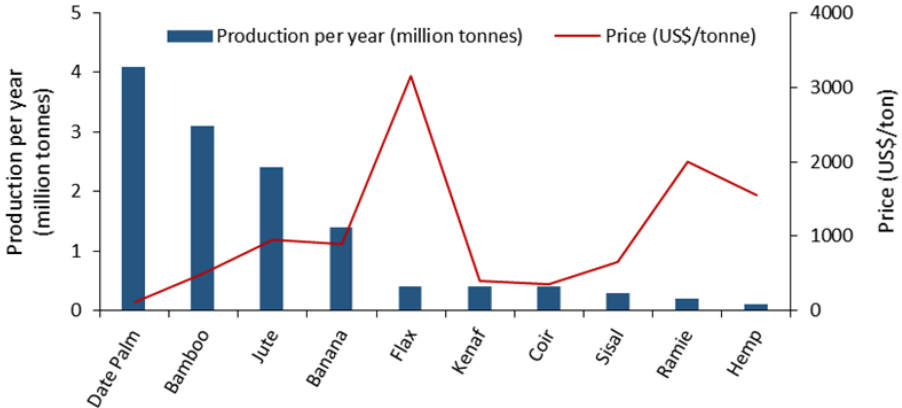
Figure 1. Production per year and price of date palm against other plants [16,17].